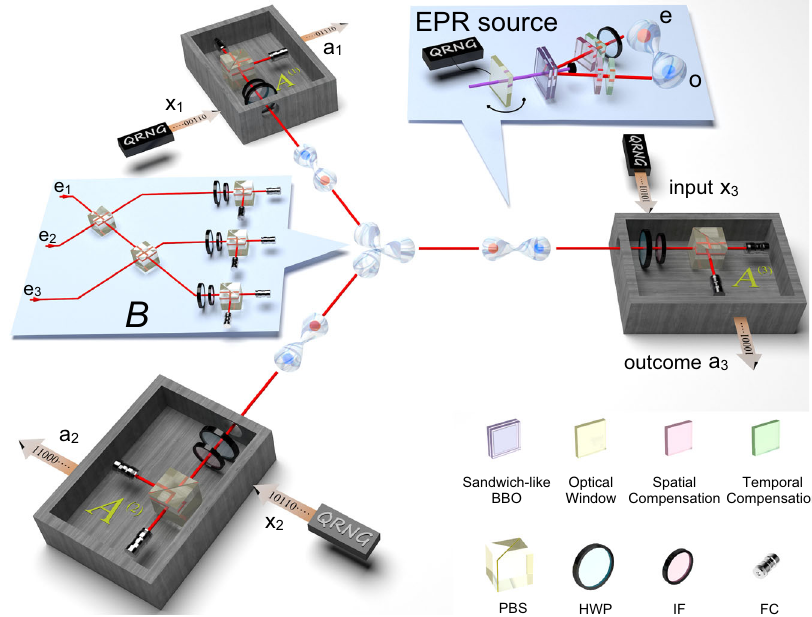
Fig. 2 | Sketch of the experimental setup. Three SPDC sources distribute maxi- mally entangled photon pairs to build a 3-star quantum network. The three extra- ordinary photons (red spheres) sent to the central node are spatially and temporally overlapped on two cascaded PBSs to complete the Hong-Ou-Mandel interference, asshownintheleftinsert.The three ordinary photons (blue spheres) are sent to the wing parties to realise single-qubit measurements in Eq. (3). The